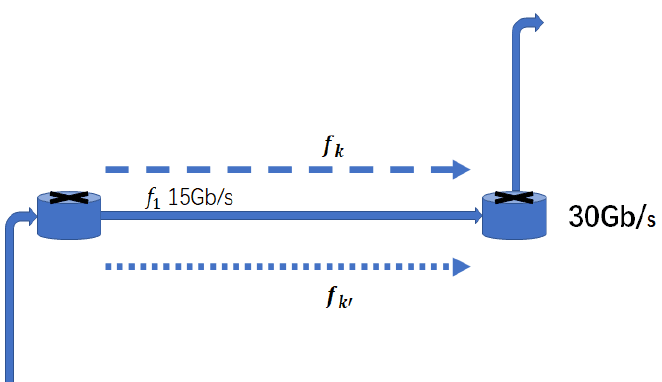
Figure 3. The bandwidth allocation between new flows ( 𝑓 𝑘 and 𝑓 𝑘′ ) and original flow (𝑓 1 ).